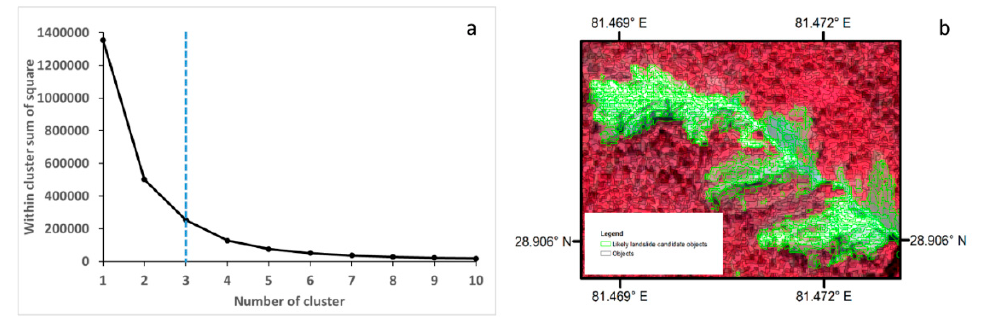
Figure 5. ( a ) Example application of the number of clusters determined using the Elbow method in which bend was calculated at 3 using Elbow point-detection method (normalized difference vegetation index (NDVI) from WV02 image of 8 October 2012); ( b ) Segmentation using scale parameter 10 and selected likely landslide candidate objects using an NDVI threshold of 0.44 (green